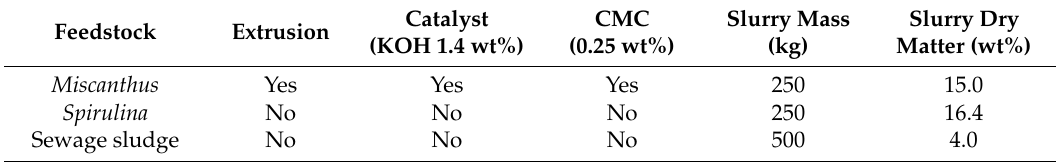
Table 2. Pre-treatment and final slurry concentrations for the different model biomass feedstocks.